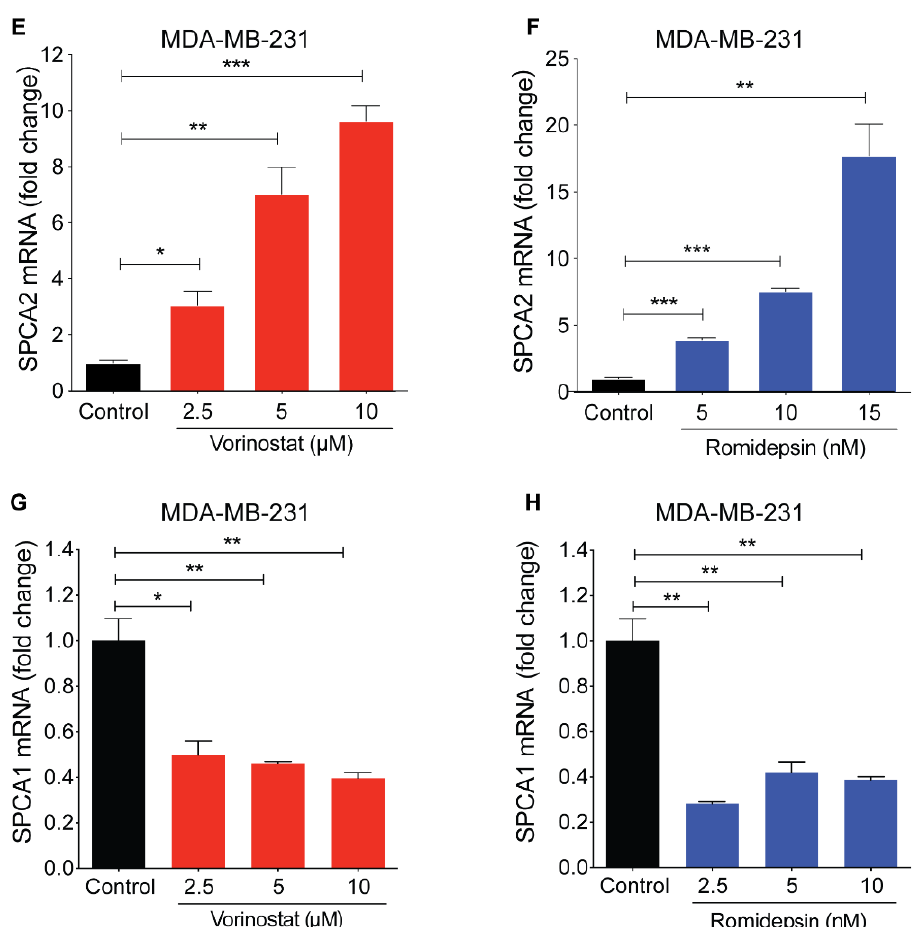
Figure 2. Epigenetic modulation of SPCA2 in TNBC. ( A ) Schematic showing hypothetical effect of histone deacetylase inhibitors (HDAC) inhibitors on SPCA2 expression. ( B ) Representative western blot of histone acetylation in MDA-MB-231 and HS578T cells after treatment with vorinostat (2.5 µM) or romidepsin (5 nM) for 24 h. GAPDH was used as a loading control ( C , D ) Quantitation of Western blots ( n = 3) by densitometry. ( E , F ) Treatment of MDA-MB-231 cells with HDAC inhibitors vorinostat (2.5, 5, 10 µM) and romidepsin (5, 10, 15 nM) for 24 h resulted in significant dose-dependence increase of the SPCA2 transcript, n = 3. ( G , H ) Treatment of MDA-MB-231 cells with HDAC inhibitors vorinostat (2.5, 5, 10 µM) and romidepsin (5, 10, 15 nM) for 24 h resulted in significant decrease of the SPCA1 transcript, n = 3. Student’s t -test, *** p < 0.001, ** p < 0.01, * p < 0.05.